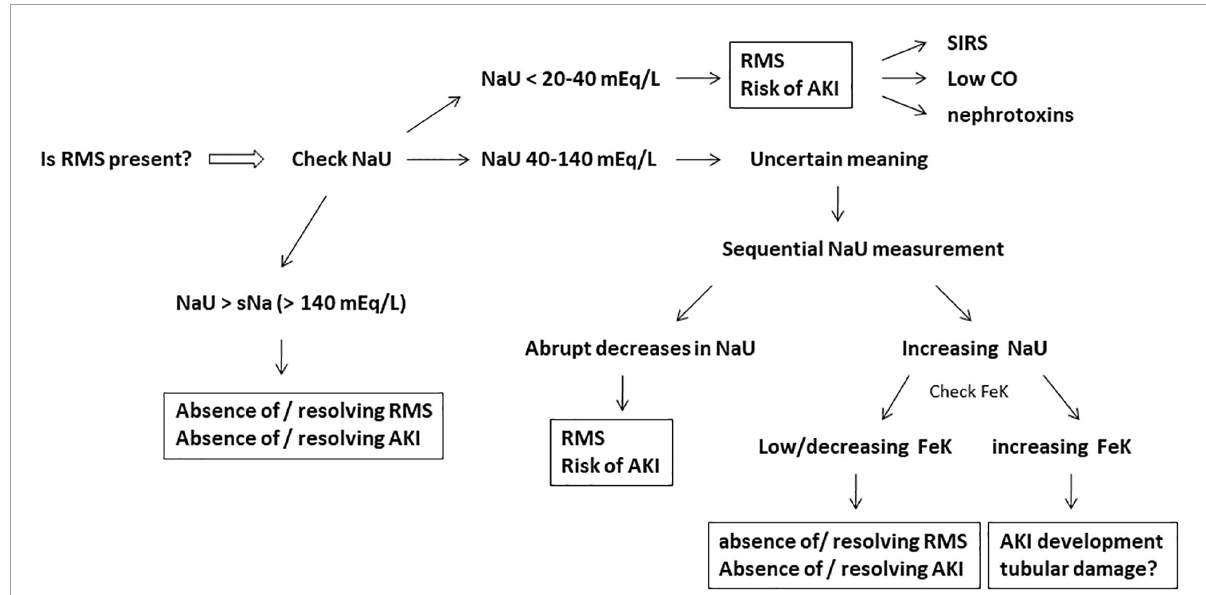
FIGURE3 Active investigation for the presence of renal microcirculatory stress (RMS), the initial stage of acute kidney injury (AKI) development. Very low or plummeting urine sodium concentration (NaU) is the hallmark of RMS. The fractional excretion of potassium (FeK) may help to work out the meaning of intermediate values of NaU (40–140 mEq/L) and the subsequent risk of AKI development. Systemic inflammatory response syndrome (SIRS), low cardiac output (CO), and nephrotoxins (iodide contrast/non-steroidal anti-inflammatory drugs/myoglobin, etc.) are potential and frequent causes of RMS. Very high NaU ( > 140 mEq/L) suggests absence of RMS/AKI or resolving